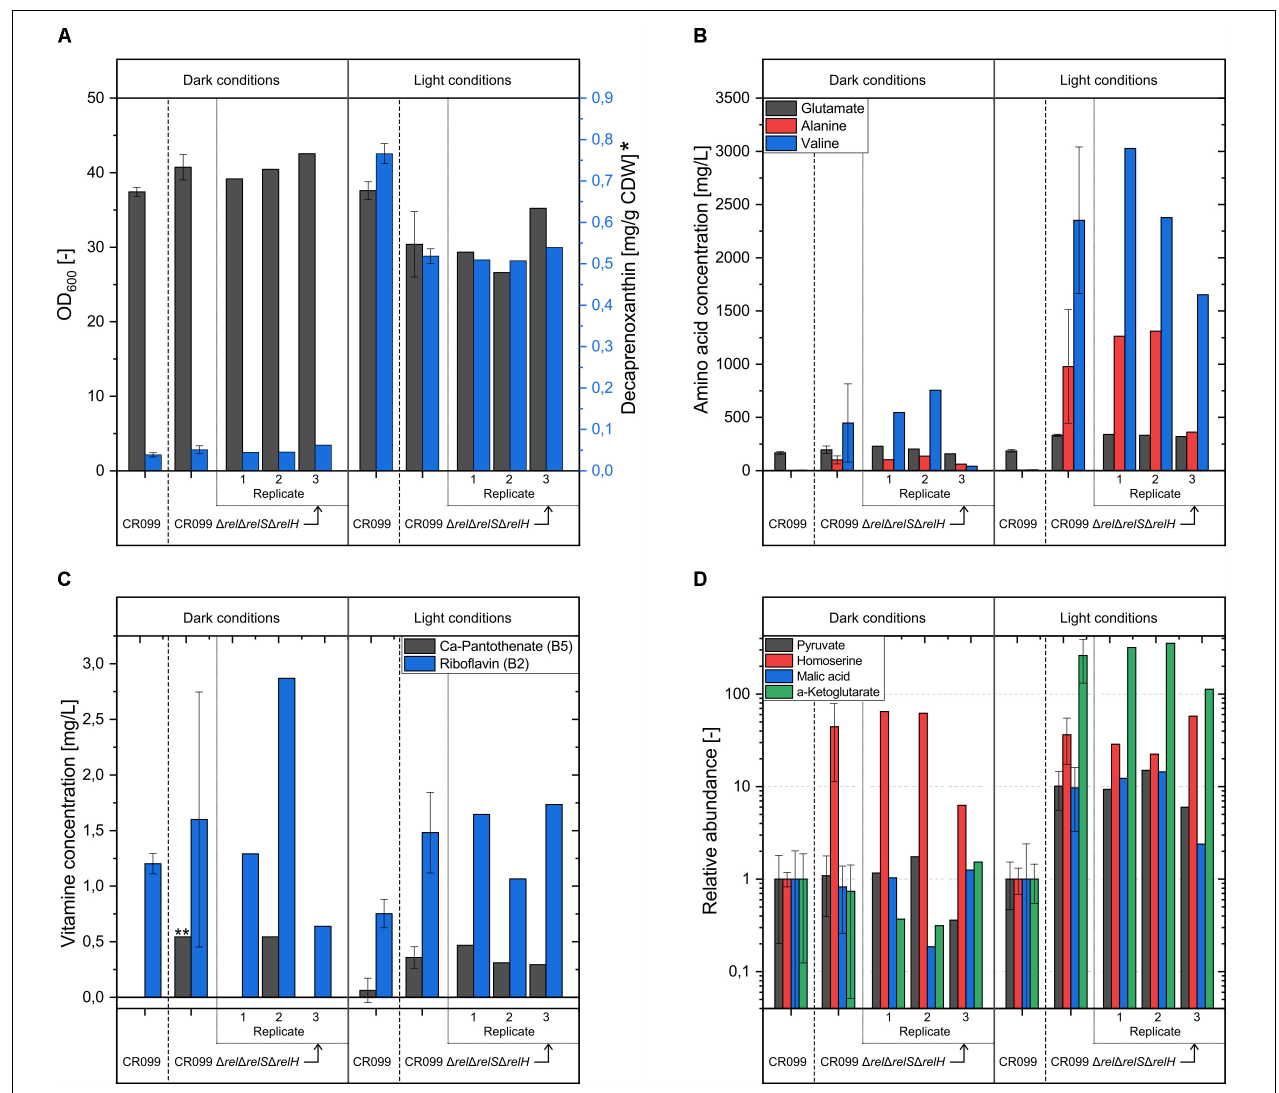
FIGURE 5 | Analysis of relevant parameters for the cultivation of C. glutamicum CR099 and C. glutamicum CR099 (cid:49) rel (cid:49) relS (cid:49) relH in dependence of illumination. Both strains were cultured in CGXII medium with supplementation of all proteinogenic amino acids (50 mg/L each) for 44 h under light and dark conditions. Due to considerable differences within the three biological replicates of the (p)ppGpp 0 strain, the mean values as well as the corresponding individual measurements are plotted. (A) OD 600 values and decaprenoxanthin concentration, determined by HPLC analysis and normalized to the cell weight used for extraction. ∗ Due to the unavailability of standards, the decaprenoxanthin concentration was calculated as ß-carotene equivalent. (B) L-glutamate, L-alanine and L-valine concentrations in supernatant, determined by OPA derivatization and HPLC measurement. (C) Supernatant concentration of water-soluble vitamins Ca-pantothenate and riboflavin, analyzed by LC-MS/MS measurement. ∗∗ Since the pantothenate concentration in two out of three replicates was below the limit of detection, only the single measured value is indicated without a corresponding error. (D) Concentrations of pyruvate, homoserine, malic acid, and α -ketoglutarate in supernatant, determined by methoxymation and silylation and subsequent GC-MS measurement. Metabolite values were normalized to the internal standard ribitol and illustrated as relative abundance, compared to the parental strain